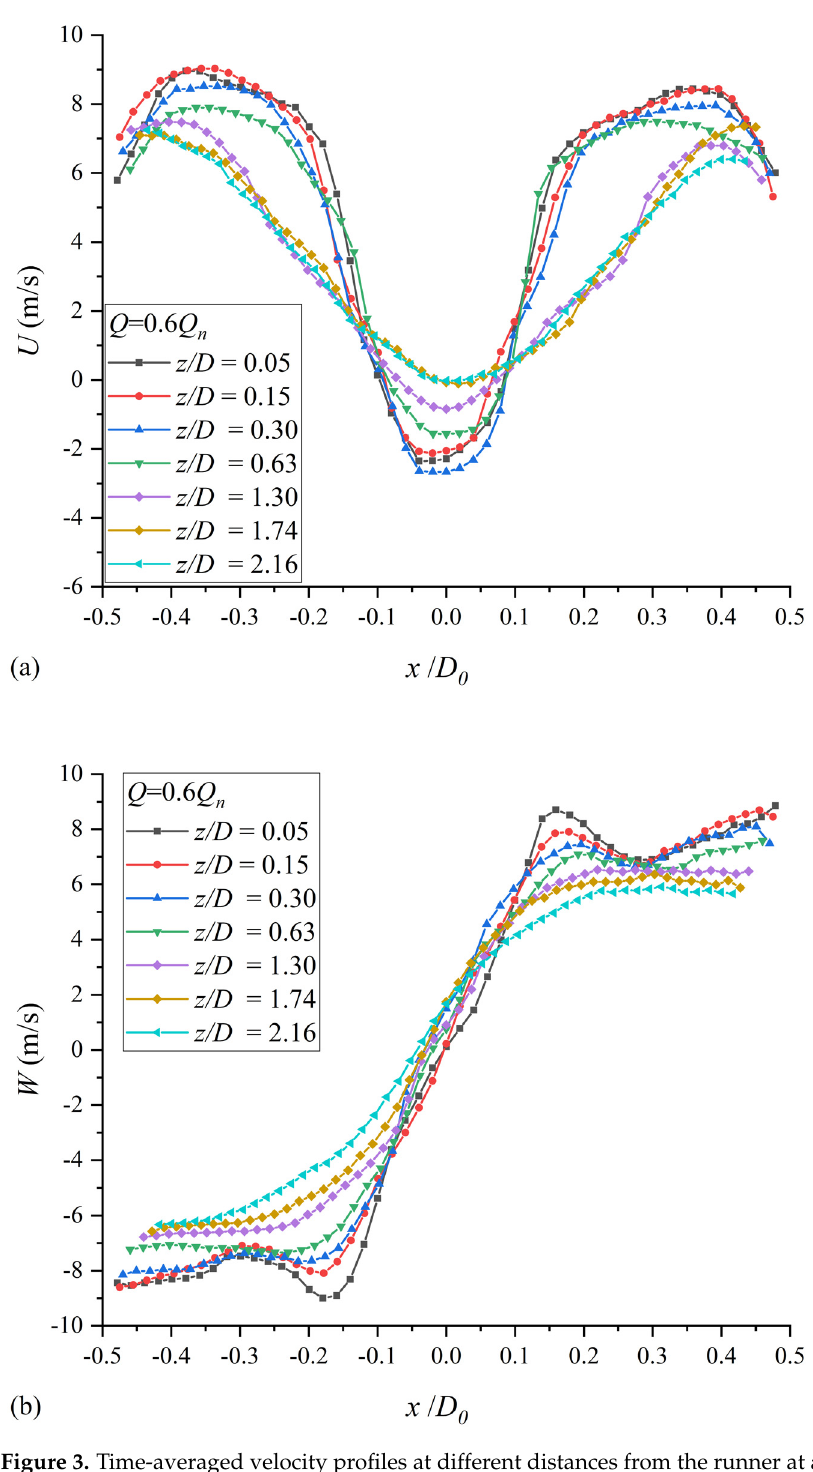
Figure 3. Time-averaged velocity profiles at different distances from the runner at a constant runner speed ω n : ( a ) Axial component; ( b ) Tangential component. Part load regime with Q = 0.6 Q n . The legend indicates the distances of the measuring section from the tip of the runner cowl. In the section z / D = 1.30 the swirl number is S = 0.6.